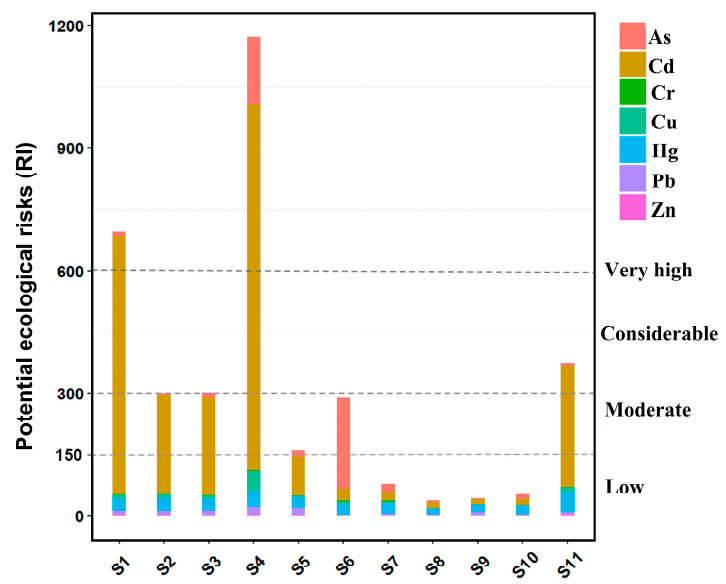
Figure 3. RI value of heavy metals in sediment (derived from the E i r value).